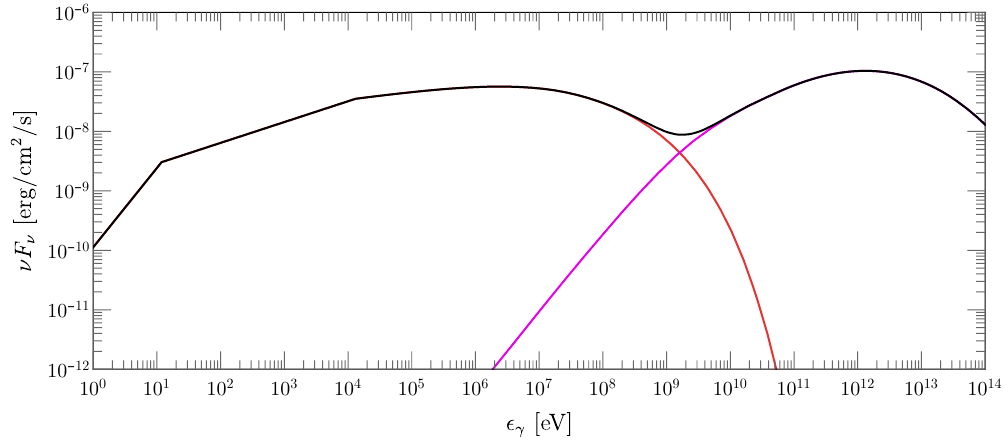
Figure 11. Example of a synchrotron-self-Compton spectrum of a gamma-ray burst (red: synchrotron, magenta: inverse Compton, black: total), at an observer time t obs = 100s ( t obs = 0 marking the onset of the prompt emission phase), taking into account the effect of a decaying microturbulence behind the shock, as described in the text. The pair-production opacity of the intergalactic radiation fields, which attenuates strongly the emission above ∼ 1TeV, has not been taken into account here. See the text for